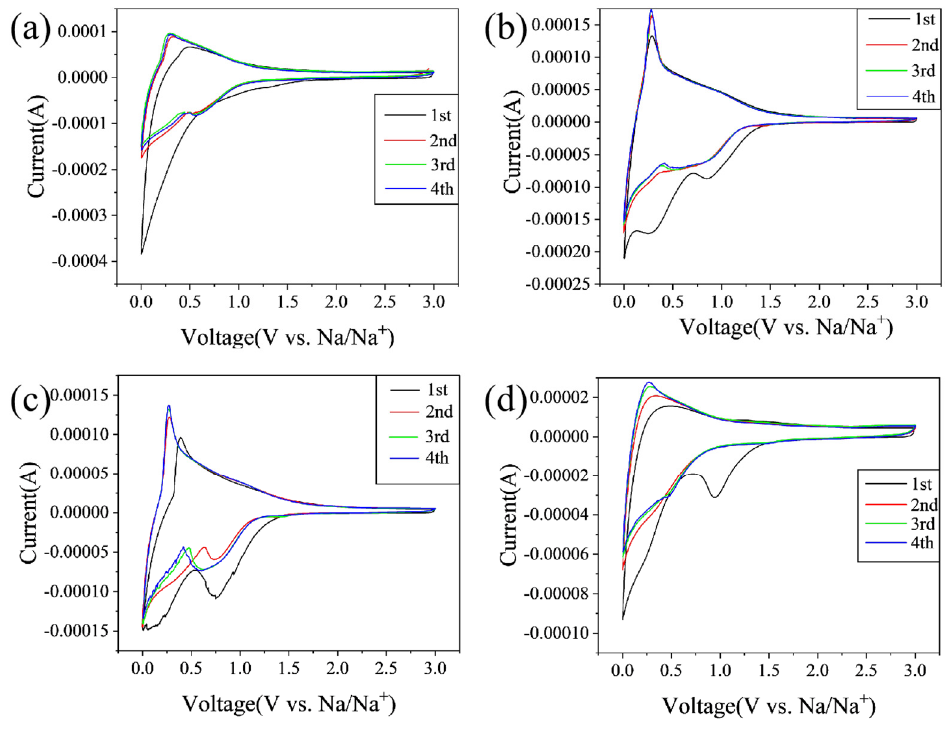
Figure 5. CV diagrams of ( a ) CC-1000, ( b ) CC-1200, ( c ) CC-1400, and ( d )